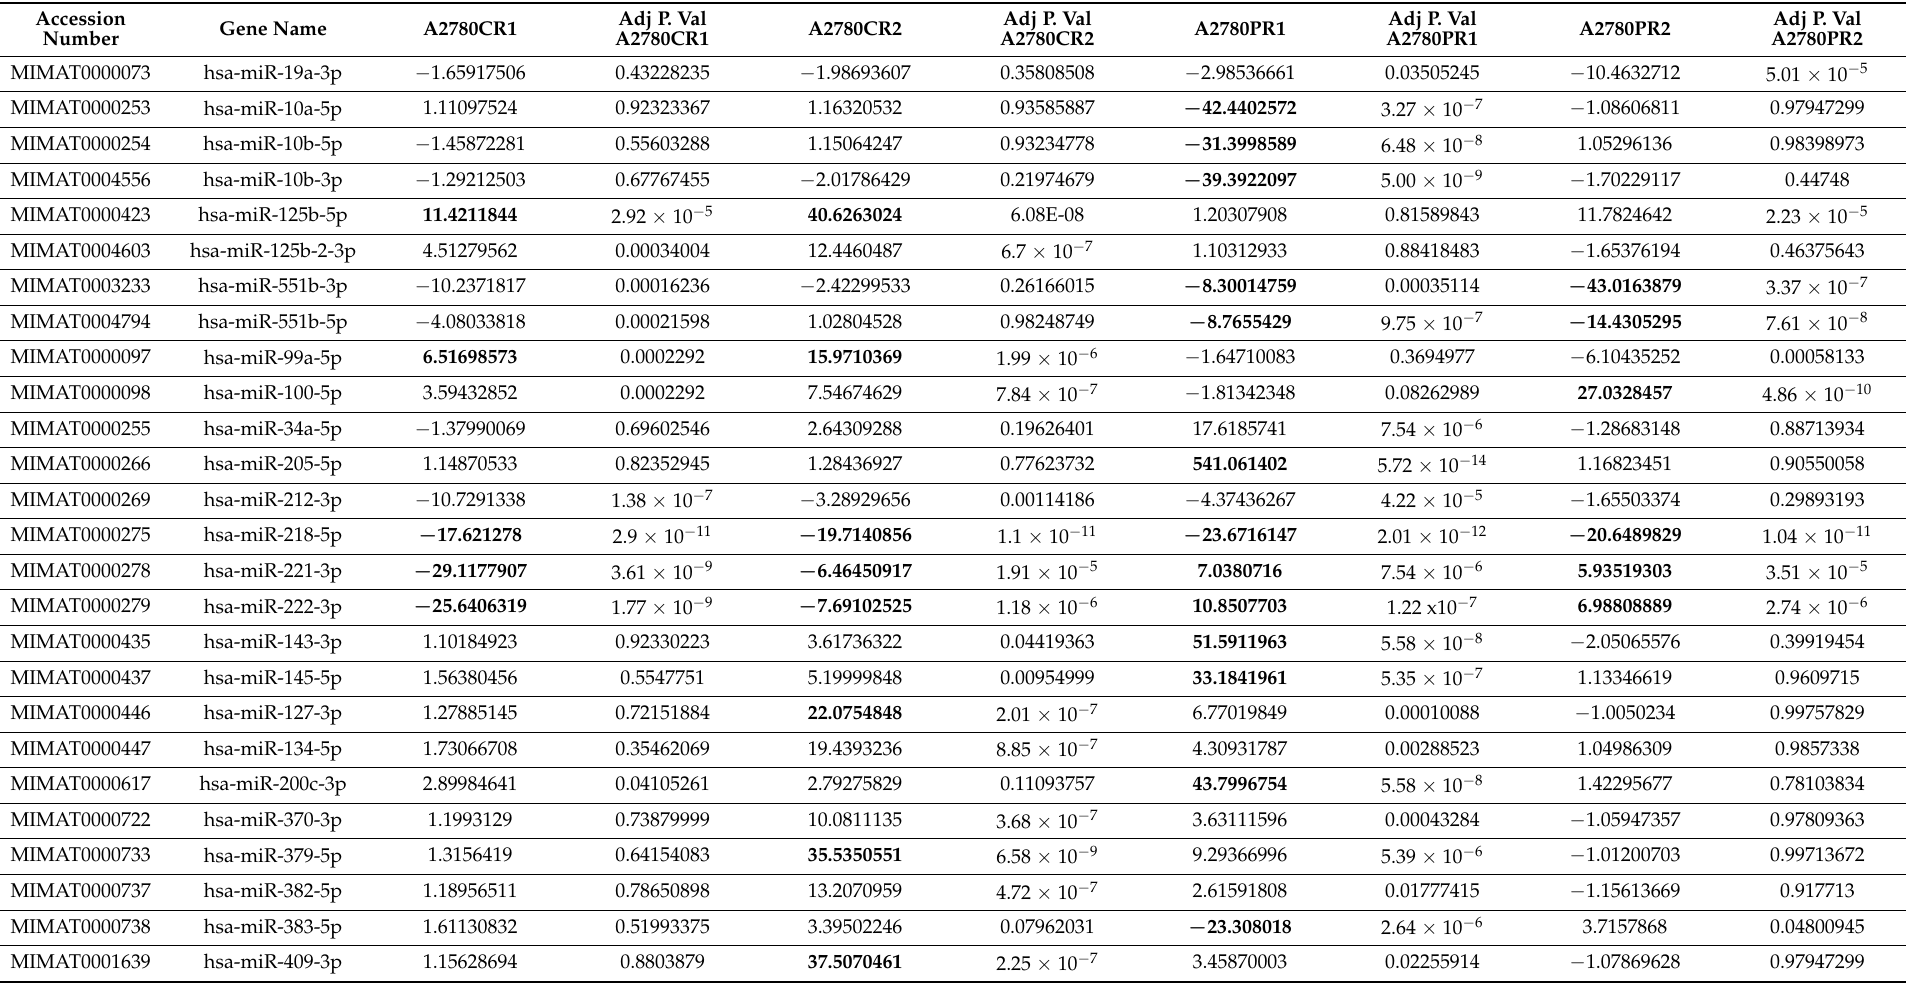
Table 1. List of the miRNA fold changes, and false discovery rate (FDR) corrected p values (adj.p.val.). Each comparison was performed in relation to A2780 cells. miRs changes in two cell lines resistant to the same drug or changes over 20-fold are